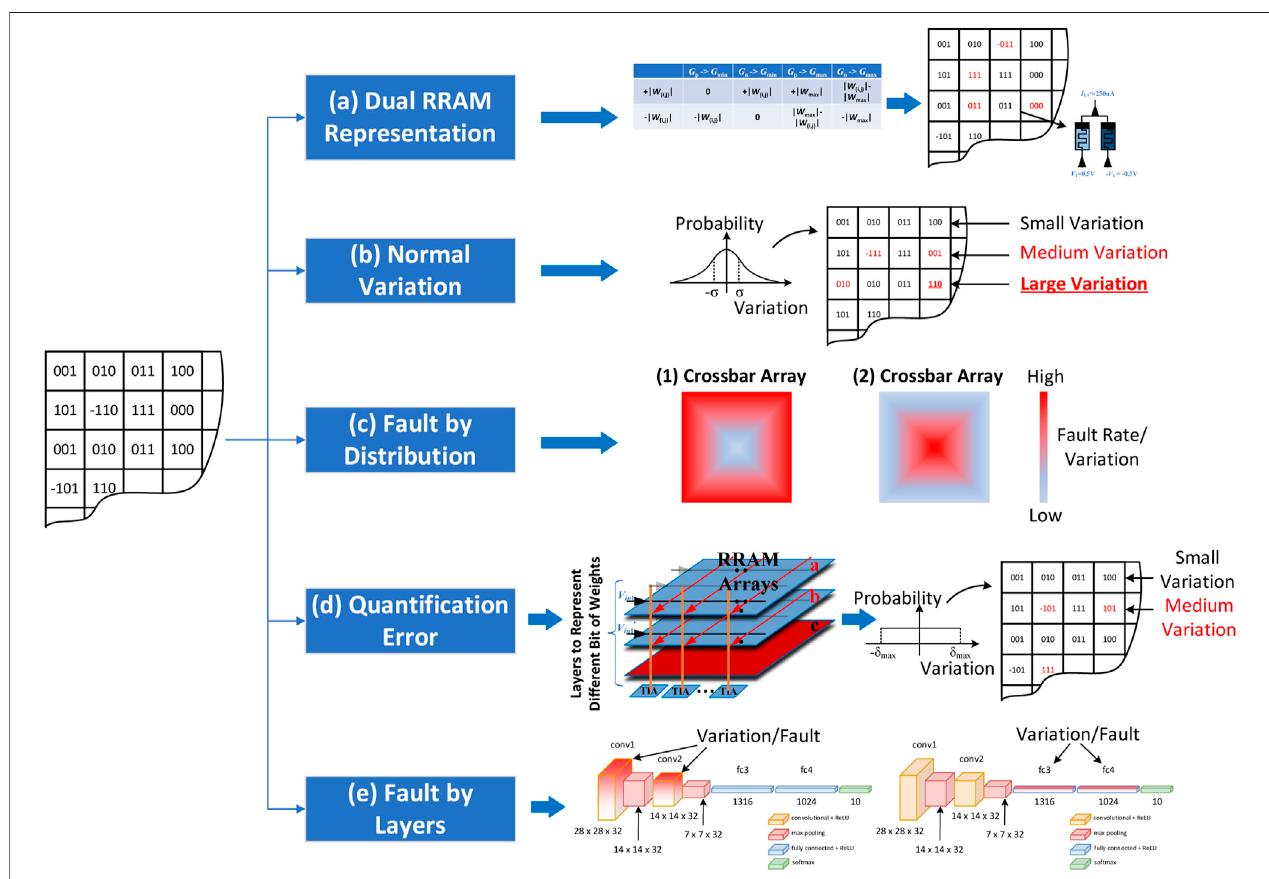
FIGURE 6 | Overview of fi ve fault/variation